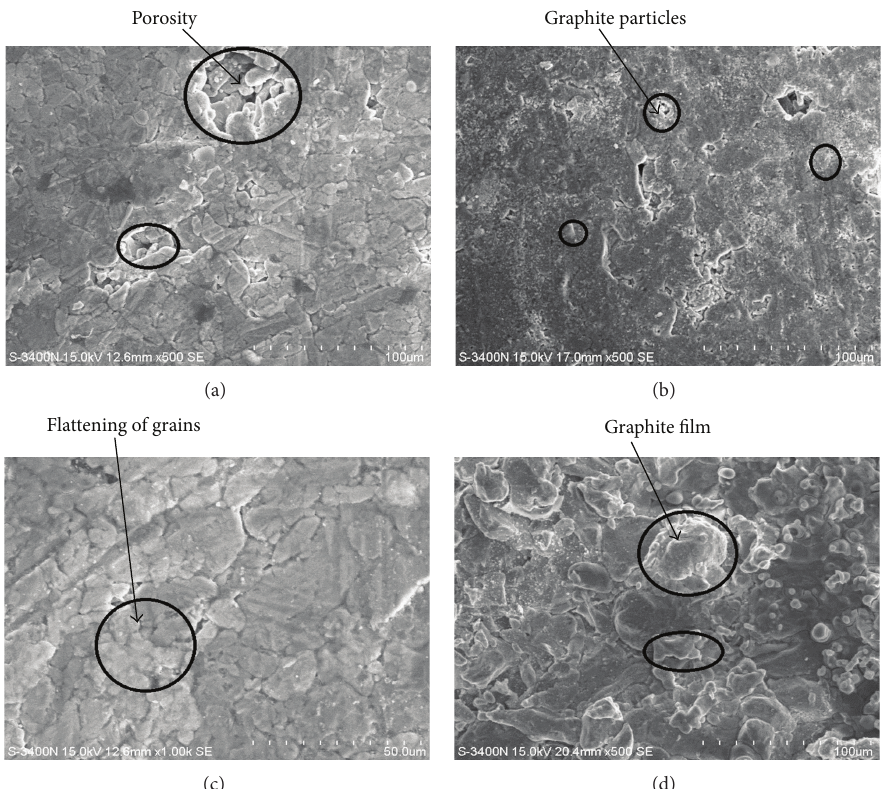
Figure 1: SEM images of aluminium-graphite composites: (a) Al + 0% graphite—low density; (b) Al + 6% graphite—low density; (c) Al + 0% graphite—high density; (d) Al + 6% graphite—high density.